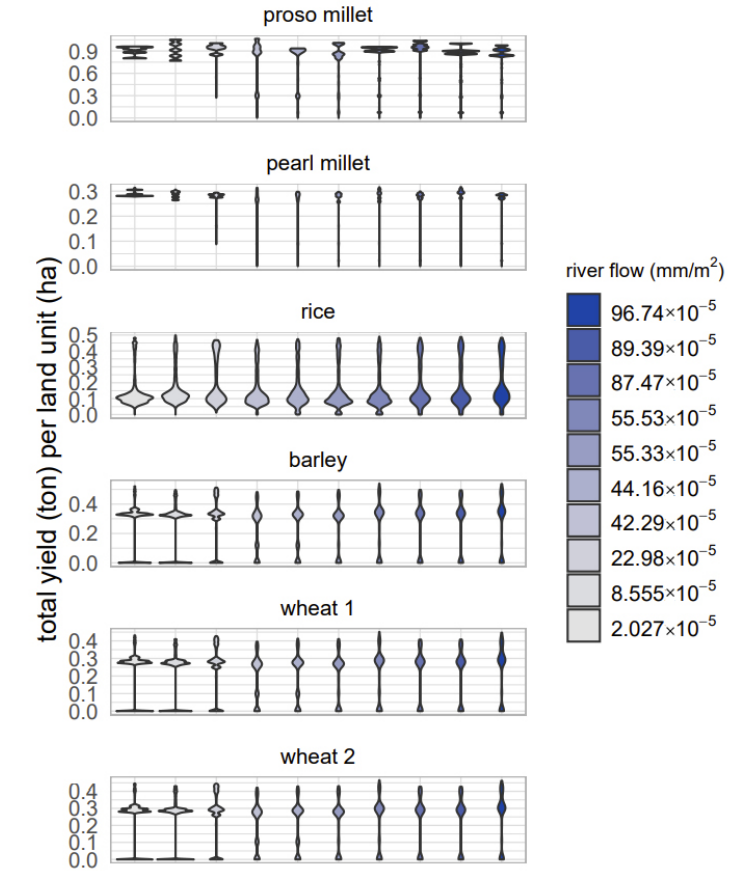
Figure 10. Production of land units per crop ( p_crop_totalYield ) for the different volumes of water per unit of flow accumulation in the river path ( riverWaterPerFlowAccumulation ) in terrain 35, as explored in experiment